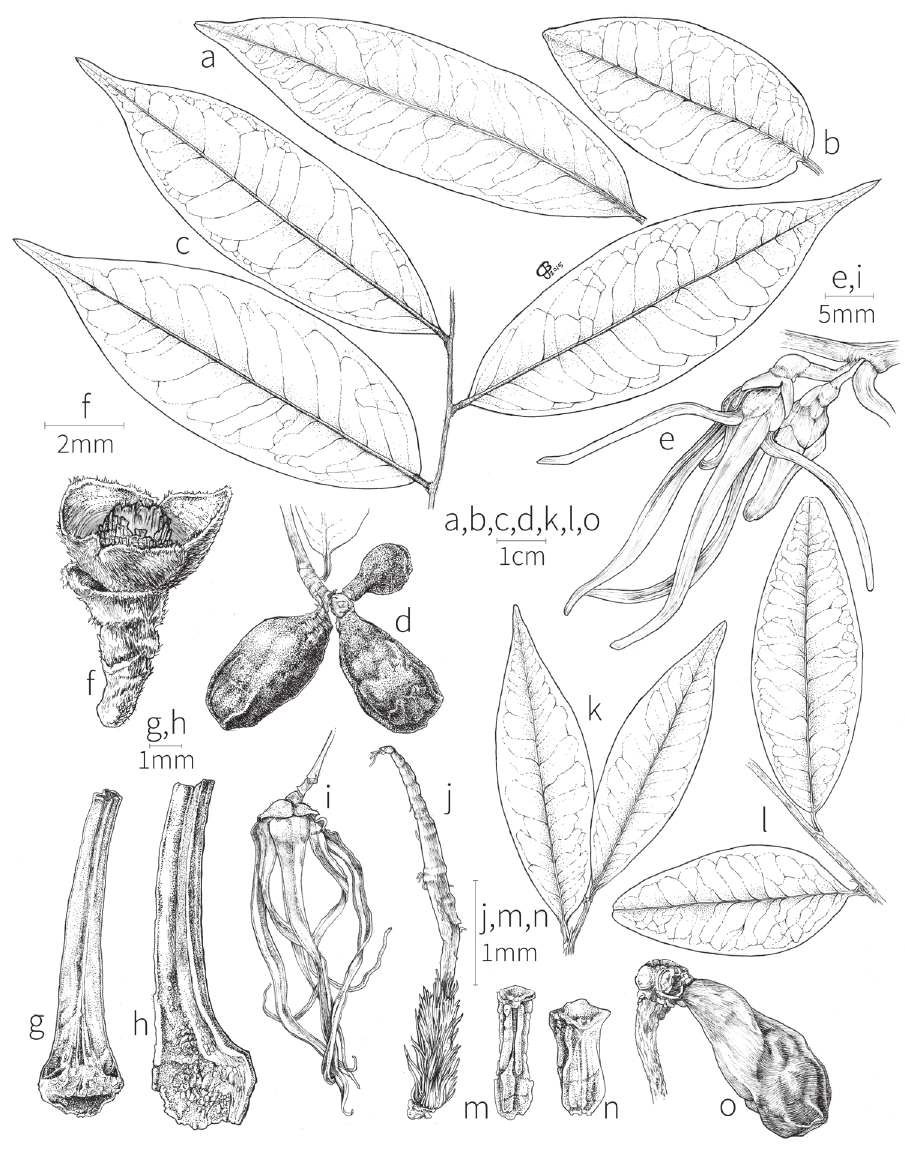
Figure 28. Xylopia keniensis and X. tanganyikensis , with leaves of X. holtzii and X. longipetala for com- parison. A Leaf of X. holtzii from Tanzania B Leaf of X. longipetala from Ghana C–E X. keniensis C Habit D Fruit E Inflorescence F–O X. tanganyikensis F Pedicel, sepals, and staminal cone G Base of inner petal, adaxial view H Base of outer petal, adaxial view I Flower, lateral view J Carpel K, L Habit M Stamen, abaxial view N Staminode, abaxial view O Fruit. A from Semsei 1718 (K) B from Jongkind & Nieuwenhuis 2130 (WAG) C, D from Luke & Robertson 2723 (MO) F–J, L–N from Nishida 57 (K) K, O from Abeid et al. 1028 (L). Reproduced with the permission of the Board of Trustees, Royal Botanic Gardens